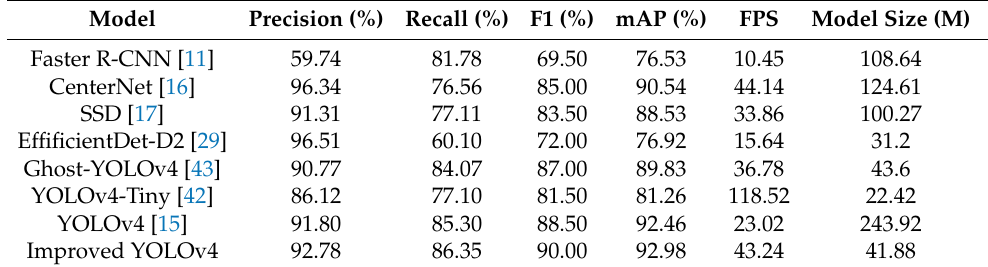
Table 2. Comparison results of different